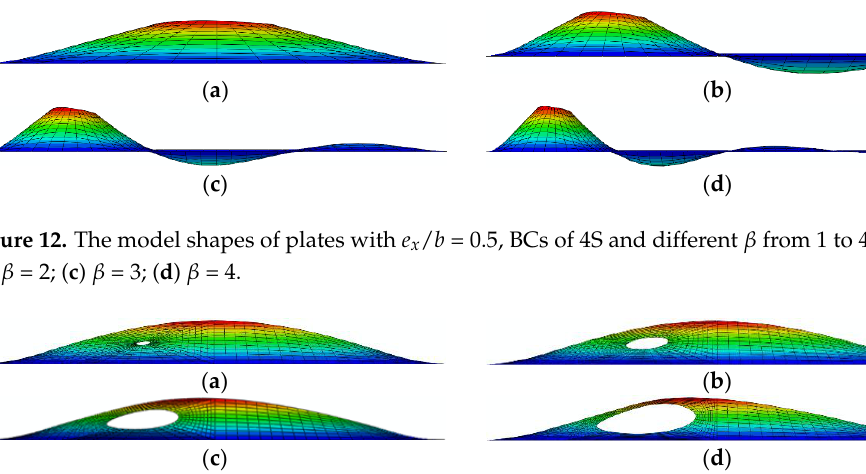
Figure 11. The model shapes of plates with e x / b = 0.5, β = 2 and BCs of 4S. ( a ) d / b = 0. 1 ; ( b ) d / b = 0.3 ; ( c ) d / b = 0.5 ; ( d ) d / b = 0.7 .